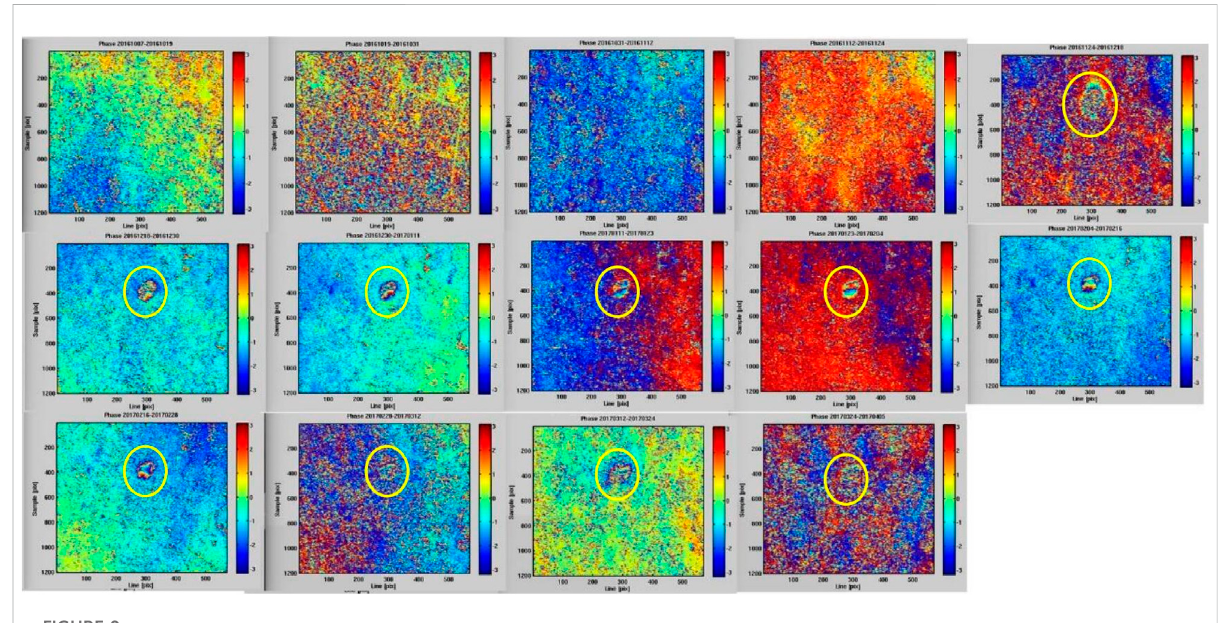
FIGURE 9 7 October 2016 to 5 April 2017 DInSAR decoding results graph.